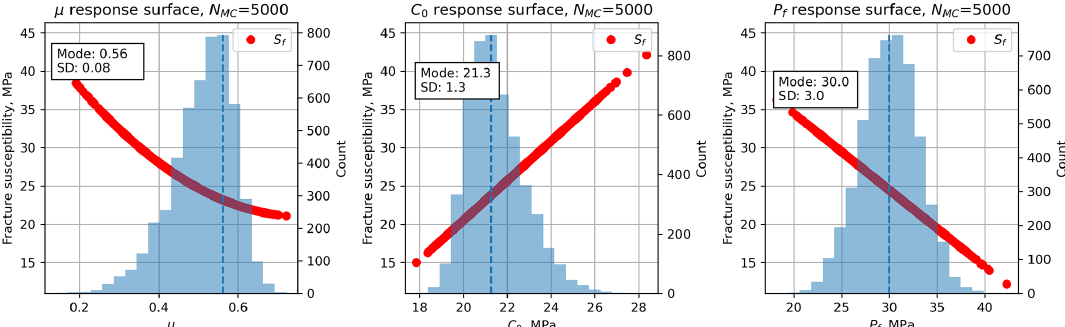
Figure 6. Histograms of the input variables (blue), in addition to those shown in Fig. 2, used to calculate fracture susceptibility ( S f ) for the synthetic distributions of worked example two shown in Table 2. Note the skewed (asymmetric) distributions for µ and C 0 .